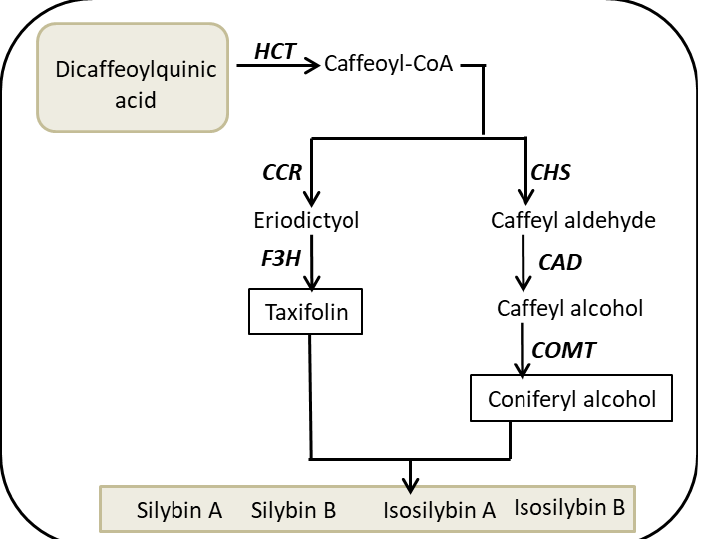
Figure 9. Proposed metabolic pathway for silybin biosynthesis. Callus extract contains dicaffeoylquinic acid ( S. marianum callus components), which is converted to caffeoyl-CoA that further metabolizes to either taxifolin or coniferyl alcohol. Both taxifolin and coniferyl alcohol are combined for synthesis of silymarin compounds.